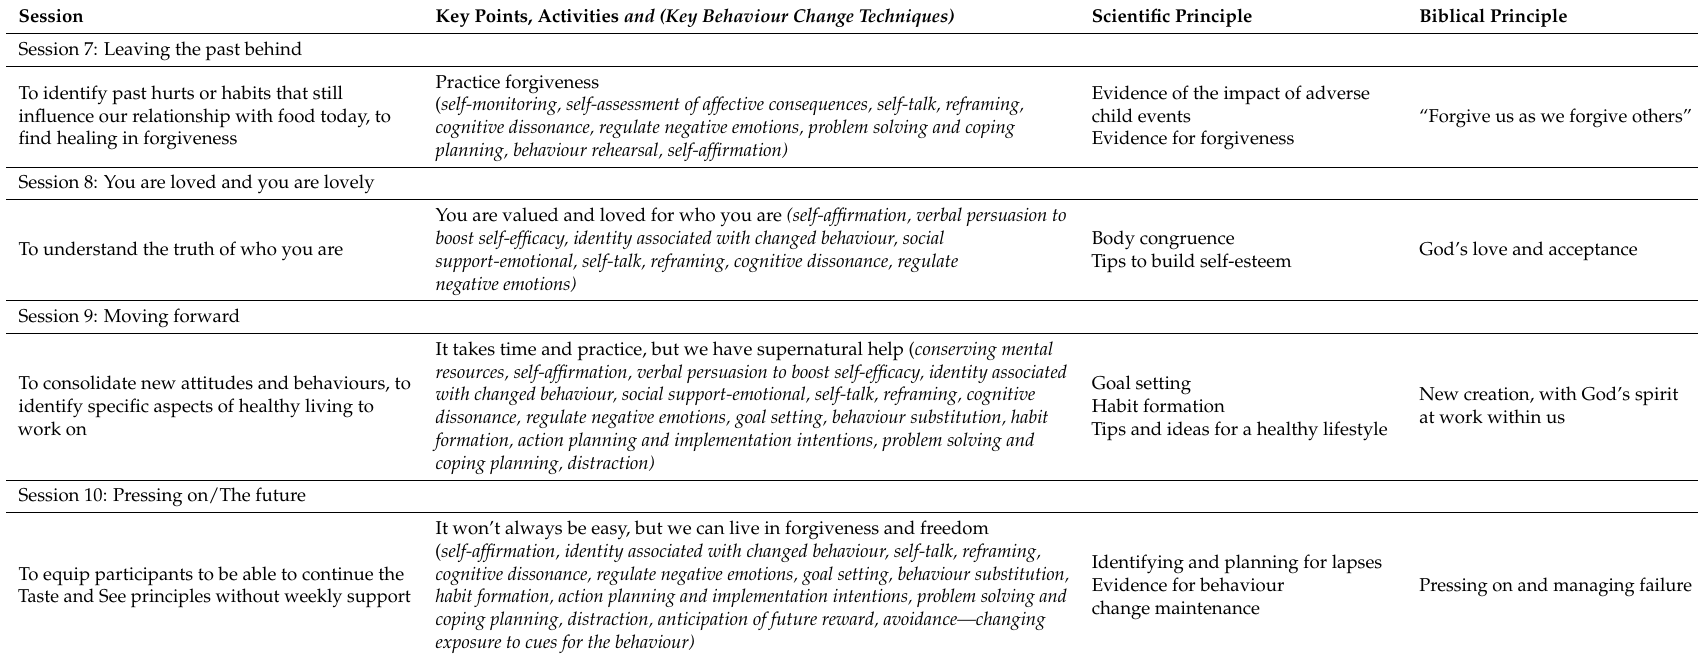
Key Points, Activities and (Key Behaviour Change